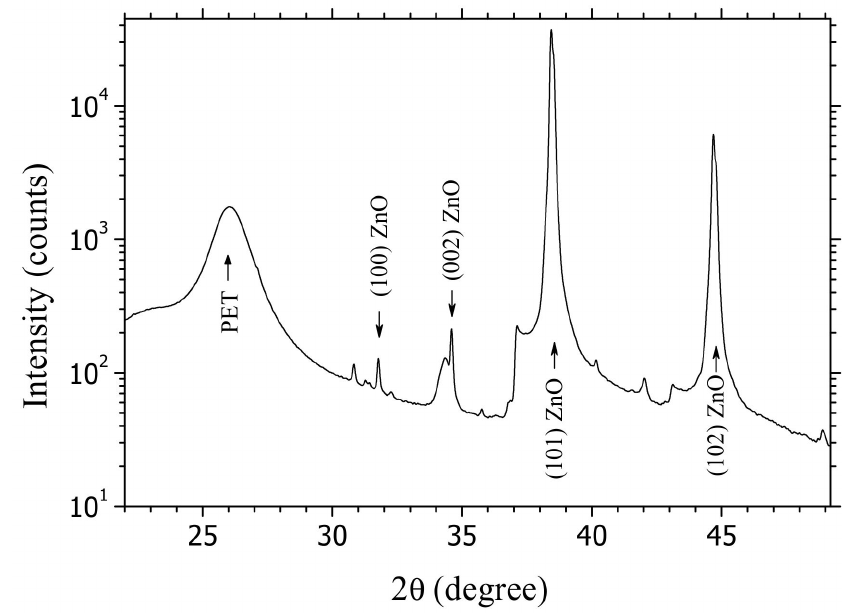
Figure 3. Typical XRD spectra for AZO layers deposited on PET substrate. The average transmission of PET substrate is high (~90%) at wavelengths over 400 nm (Figure 4a), because the regular reflectance (R reg ) [58] at the interface PET/air is low, R reg = 0.049, considering the refractive index of PET, n PET = 1.57 [59]. The interference fringes situated in the NIR region are correlated with the interference phenomenon which appears inside the substrate. All the AZO films deposited by PLD on PET substrates were characterized by high average transparencies (~90%) in the spectral range 400–800 nm. The UV-Vis transmission curves of PET/AZO samples (Figure 4a) were drawn using the PET substrates as reference samples. The transmission of the structure PET/AZO is higher than the transmission of the PET substrate alone because AZO (n AZO = 1.95 [60]) film acts as an anti-reflection layer. The R reg at the interface PET/AZO (R reg = 0.012) is much lower than R reg at the interface PET/air (R reg =